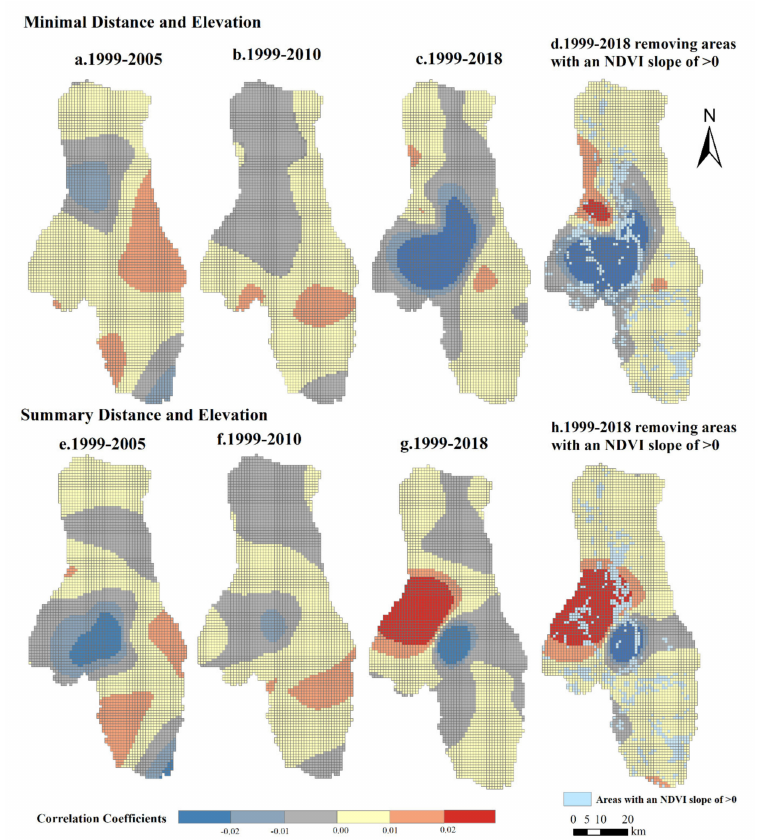
Figure 7. ( a – h ) Spatial patterns of correlation coe ffi cients between distance and vegetation changes. ( a – d ) Minimal distance and elevation, and ( e – h ) summary distance and elevation in